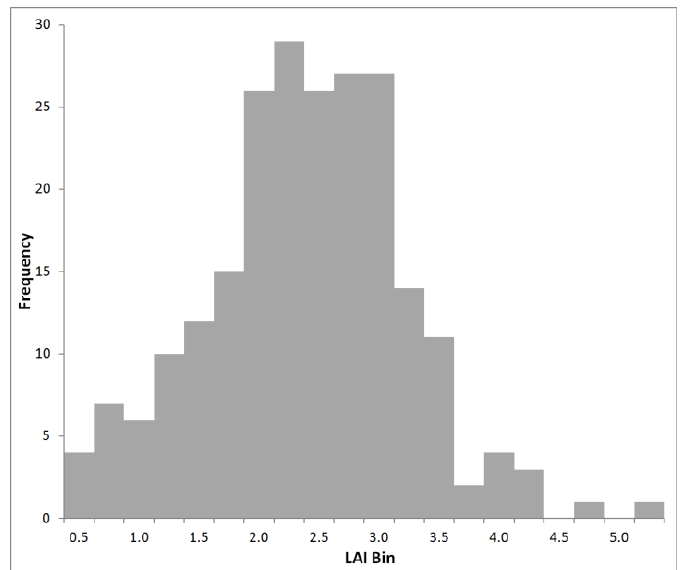
Figure 9. Frequency Histogram of LAI values from 225 final model plots.